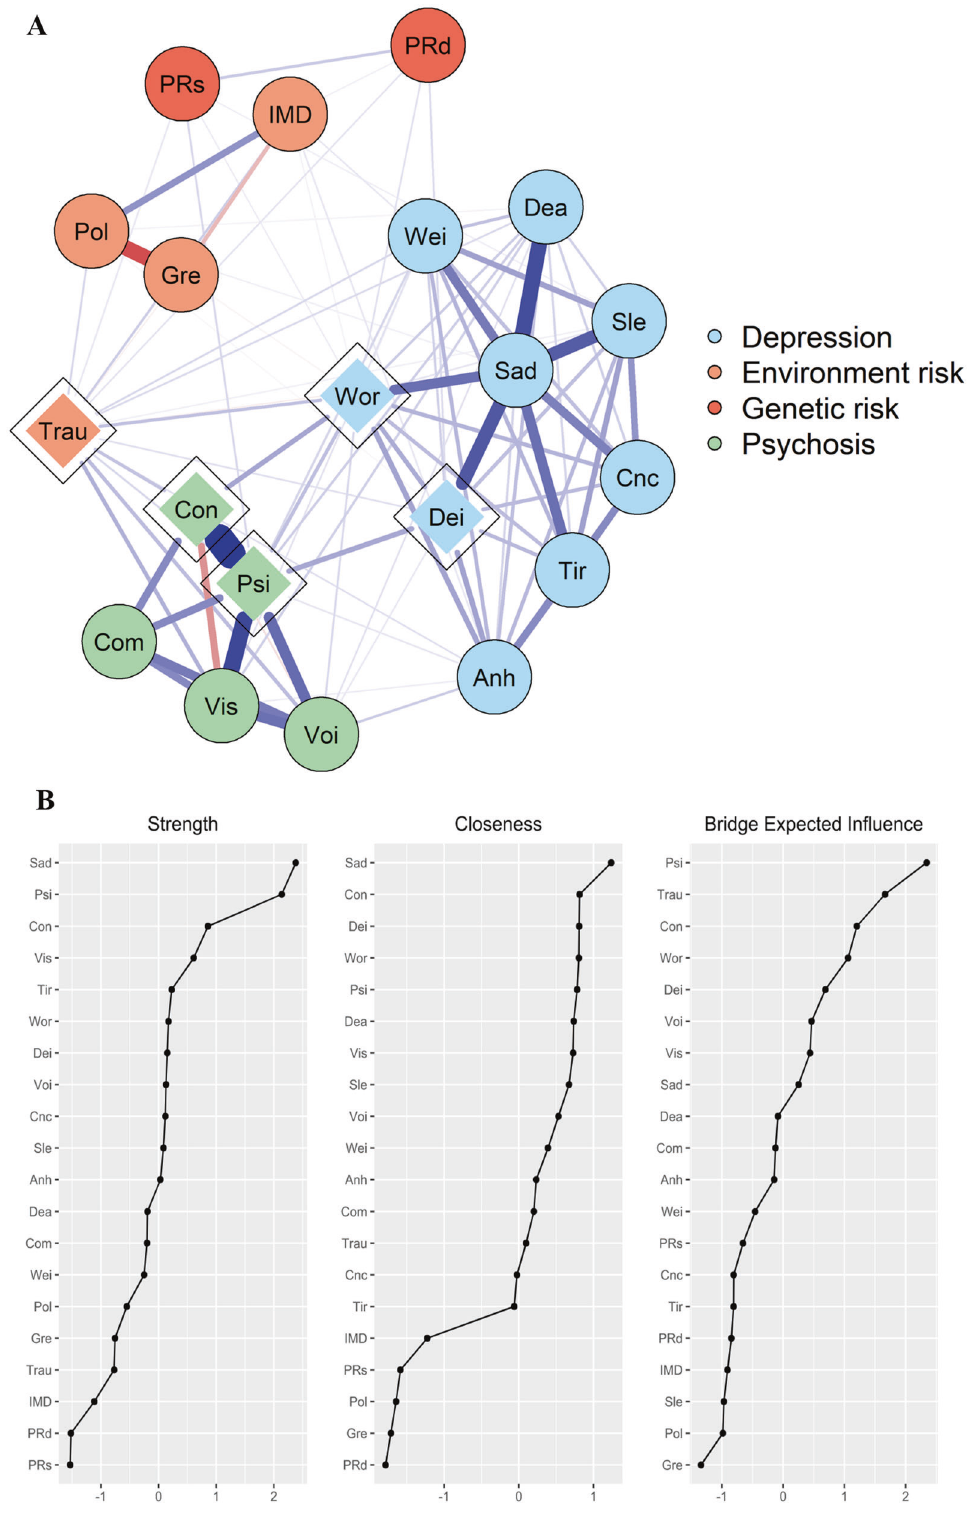
Fig. 2 Network of depression and psychosis symptoms with polygenic and environmental risk factors in the UK Biobank study. A Symptom groups, polygenic factors, and environmental risk factors are represented with different colors; bridge nodes are depicted with a diamond shape. Edges (lines) can be interpreted as partial correlations, with edge thickness representing the strength of the correlation. Blue edges represent positive associations; red edges represent negative associations. B Centrality indices and bridge expected in fl uence index for Step-2 network. Anh = anhedonia; Cnc = dif fi culty concentrating; Com = beliefs in unreal communications; Con = beliefs in unreal conspiracy against self; Dea = thoughts of death; Dei = depression impairment; Gre = greenspace; IMD = Index of Multiple Deprivation; Pol = air pollution; PRd = depression PRS; PRs = schizophrenia PRS; Psi = psychosis impairment; Sad = feelings of sadness/depression; Sle = sleep changes; Tir = feelings of tiredness; Trau = cumulative trauma; Vis = seeing unreal visions; Voi = hearing unreal voices; Wei = weight change; Wor = feelings of worthlessness